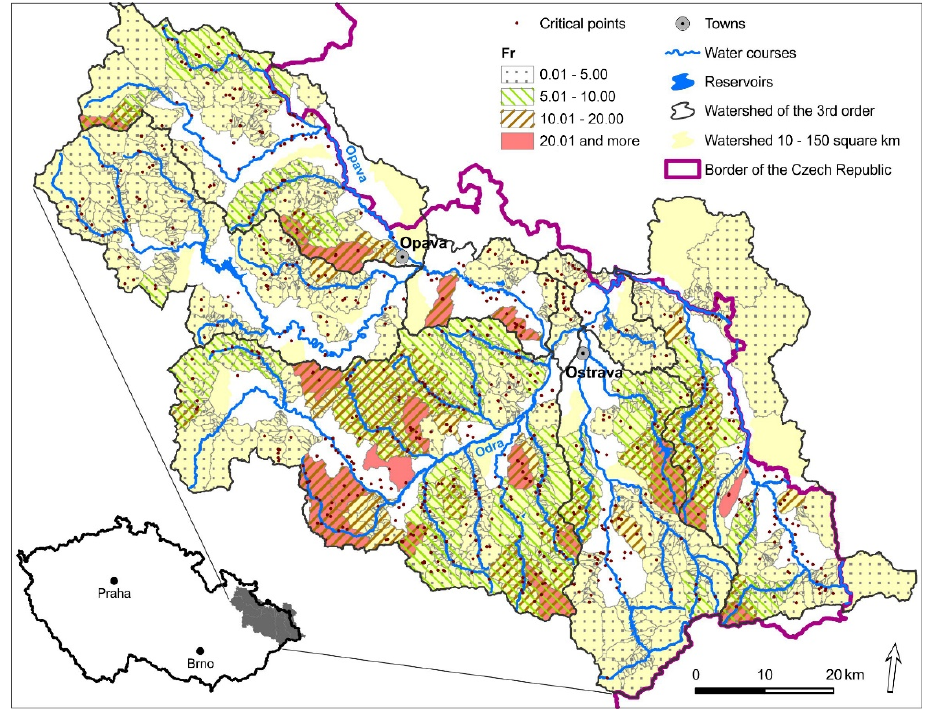
Figure 8. The group of watersheds 201–202–203 with categories of reduced value of weighted average of the indicator of critical conditions F r .